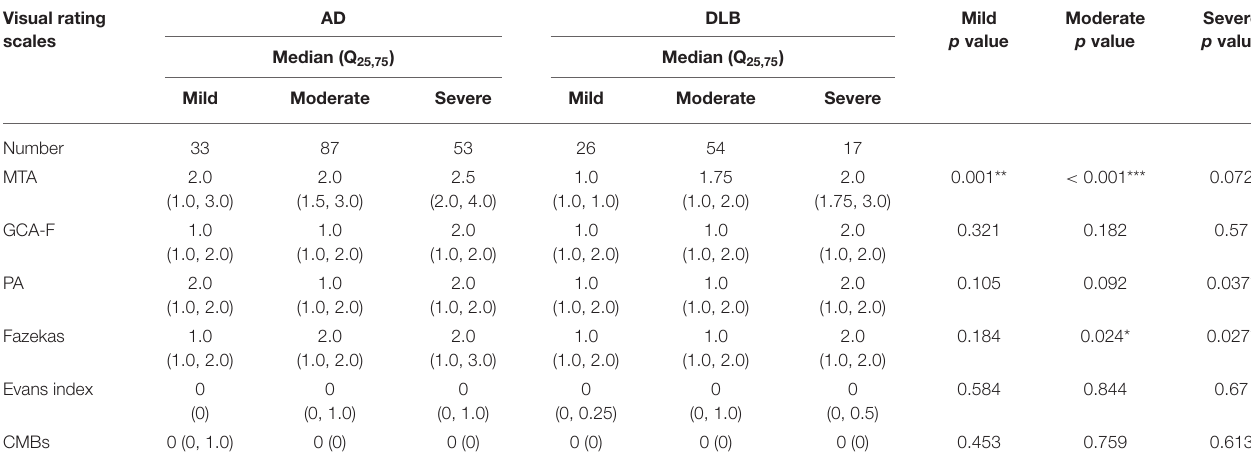
TABLE 3 | MRI visual rating scales in AD and DLB subjects with different severities. Visual rating scales